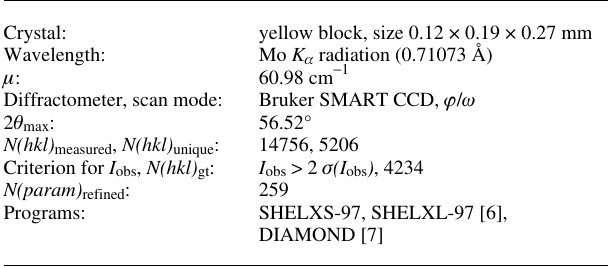
Table 1. Data collection and handling.